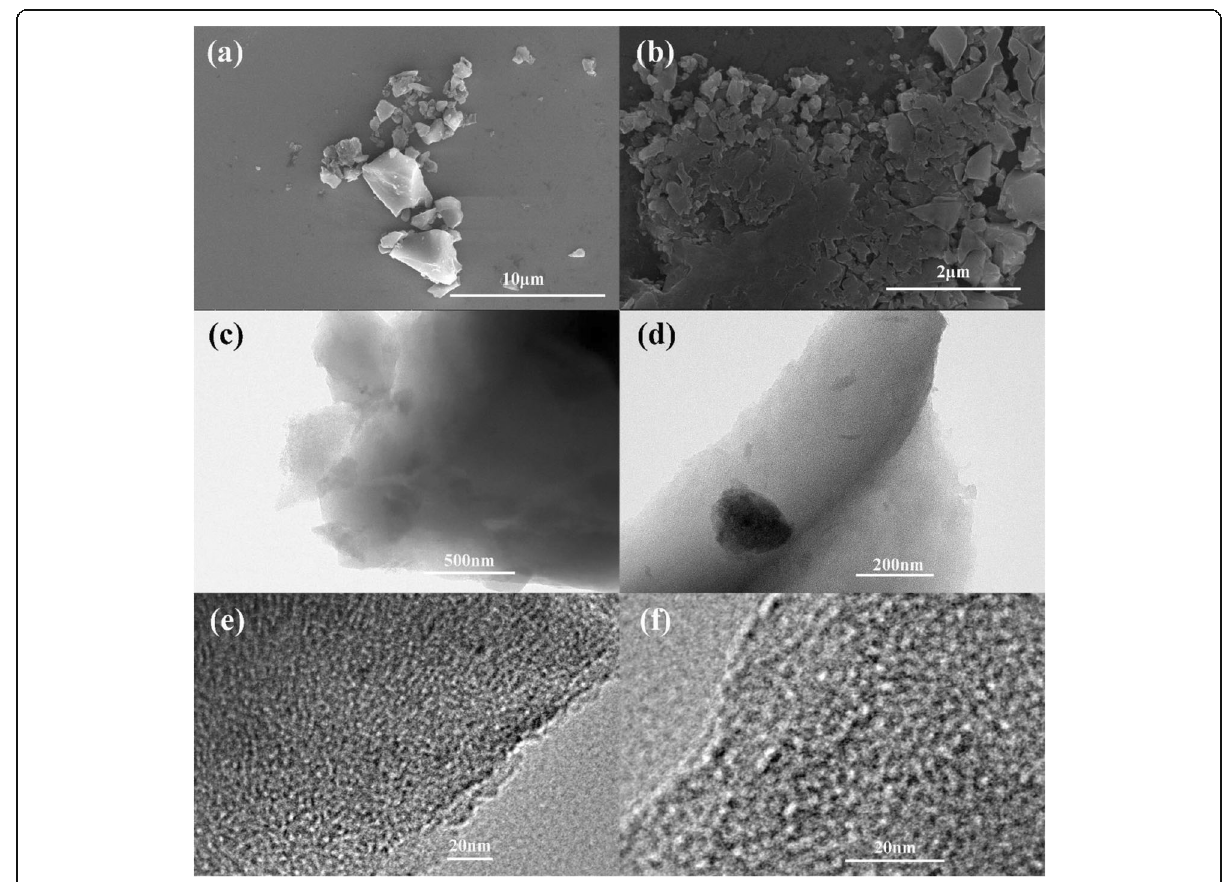
Fig. 3 a SEM image of AC-500. b SEM image of CAC-500. c TEM pattern of AC-500. d TEM pattern of CAC-500. e HRTEM pattern of AC-500. f HRTEM pattern of